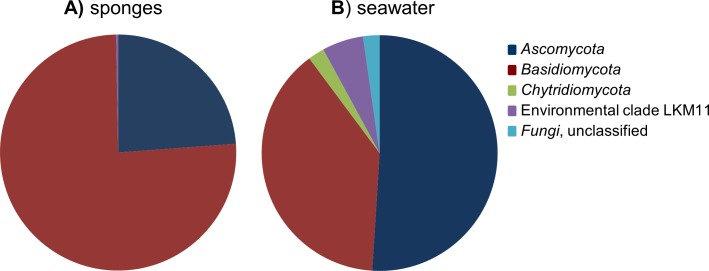
Relative abundance of fungal phyla found in the cumulative sponge and seawater samples.